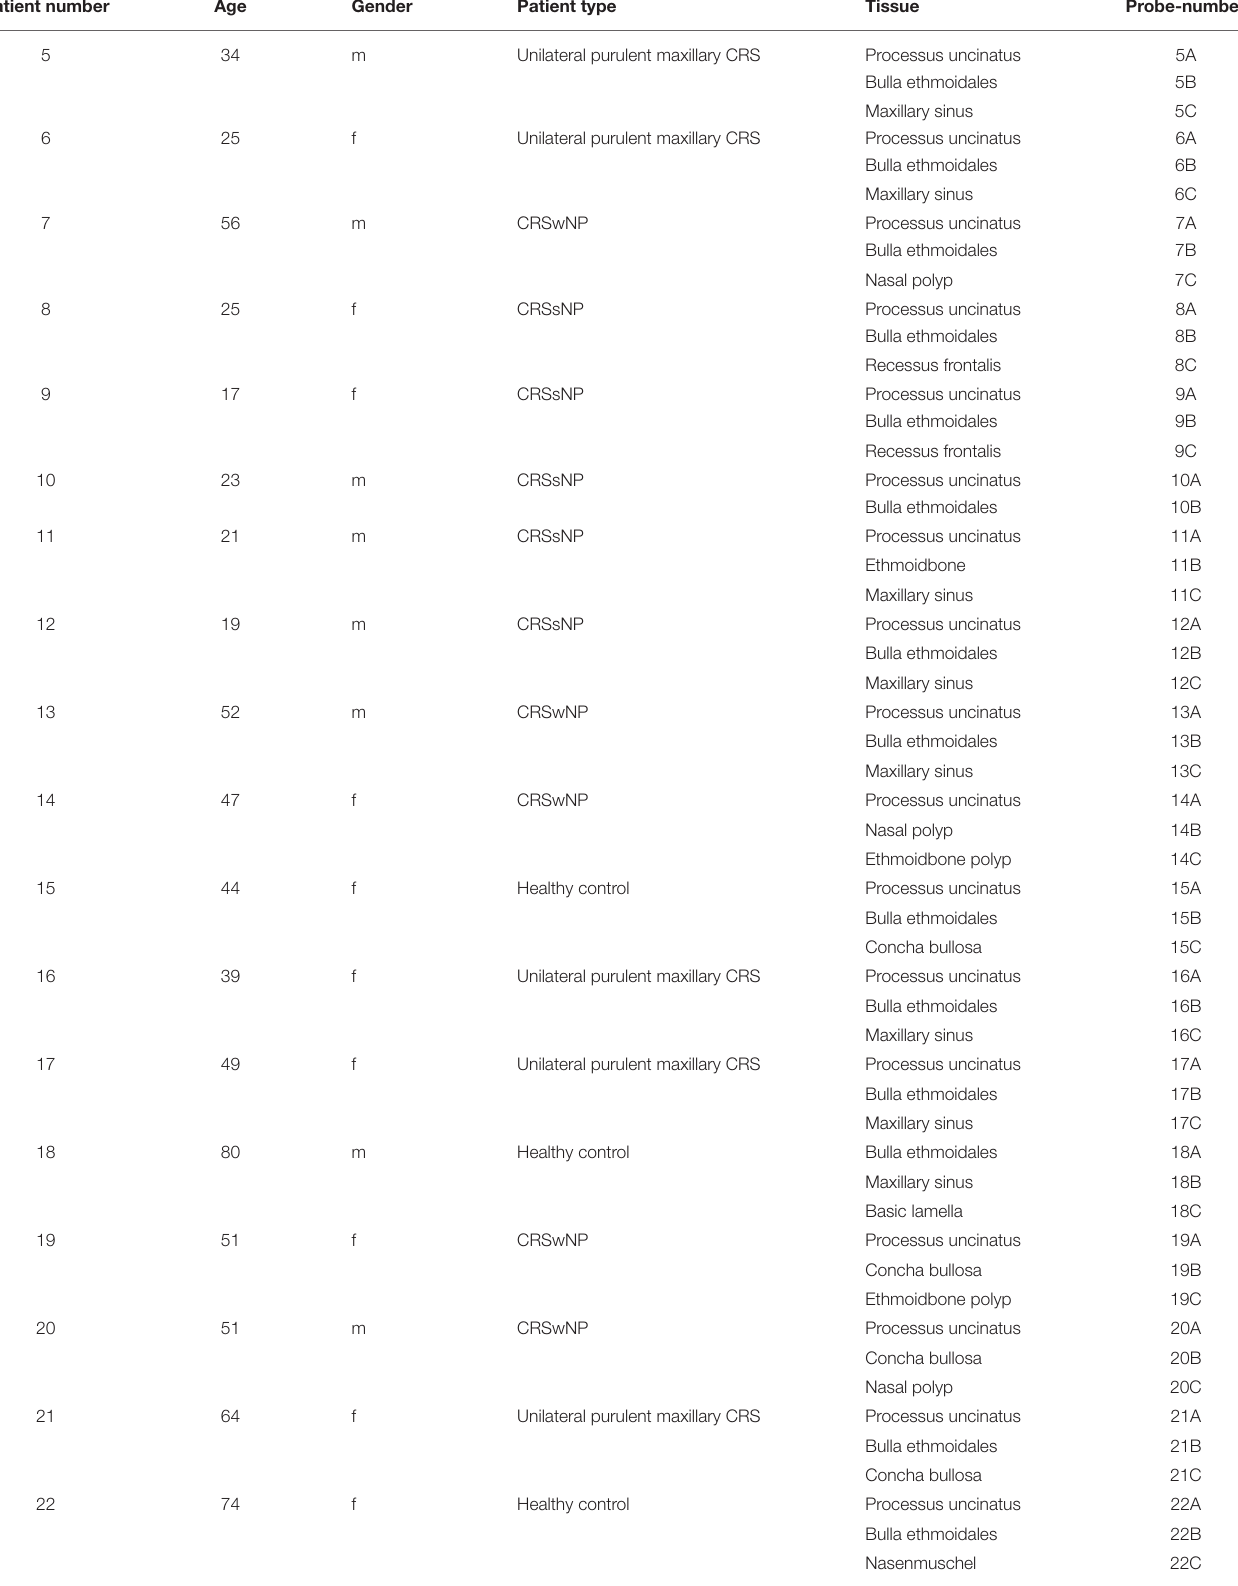
TABLE 3 | Overview of the sampled tissues with age and gender of each patient. “m”: male, “f”: female. Patient